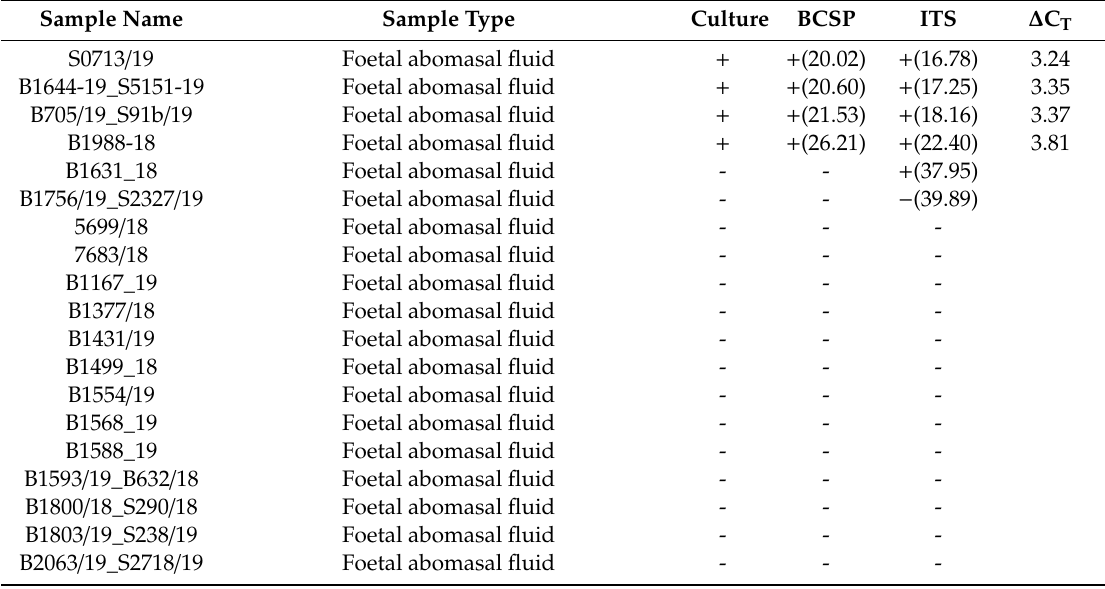
Table 6. Comparison of bacterial culture, BCSP31 and ITS qPCR assays for the diagnosis of Brucella spp. from foetal abomasal fluid and foetal tissue samples. Cut-o ff values of + < cycle threshold [36] = 38.00 > − were used to categorise positive ( + ) and negative ( − ) samples for both the BCSP31 and